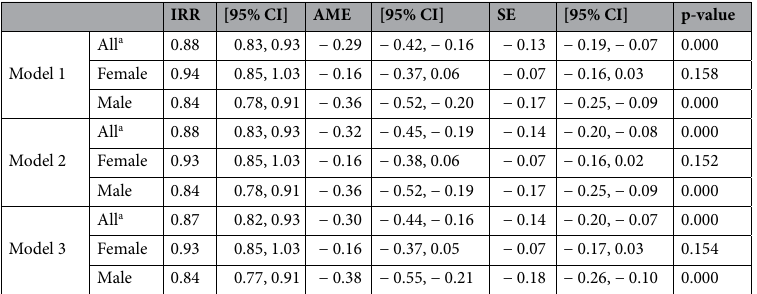
Table 2. The relation of childhood hearing loss to the number of children ever born. IRR incidence rate ratio, AME average marginal effect (change in number of children), SE Semi-elasticity (proportional change in number of children). Model 1—adjusted for age. Model 2—adjusted for age, mother and father’s education. Model 3—adjusted for age, mother and father’s education and self-reported health, systolic and diastolic blood pressure, motor, visual, somatic and mental impairment, and smoking. a Also adjusted for sex.